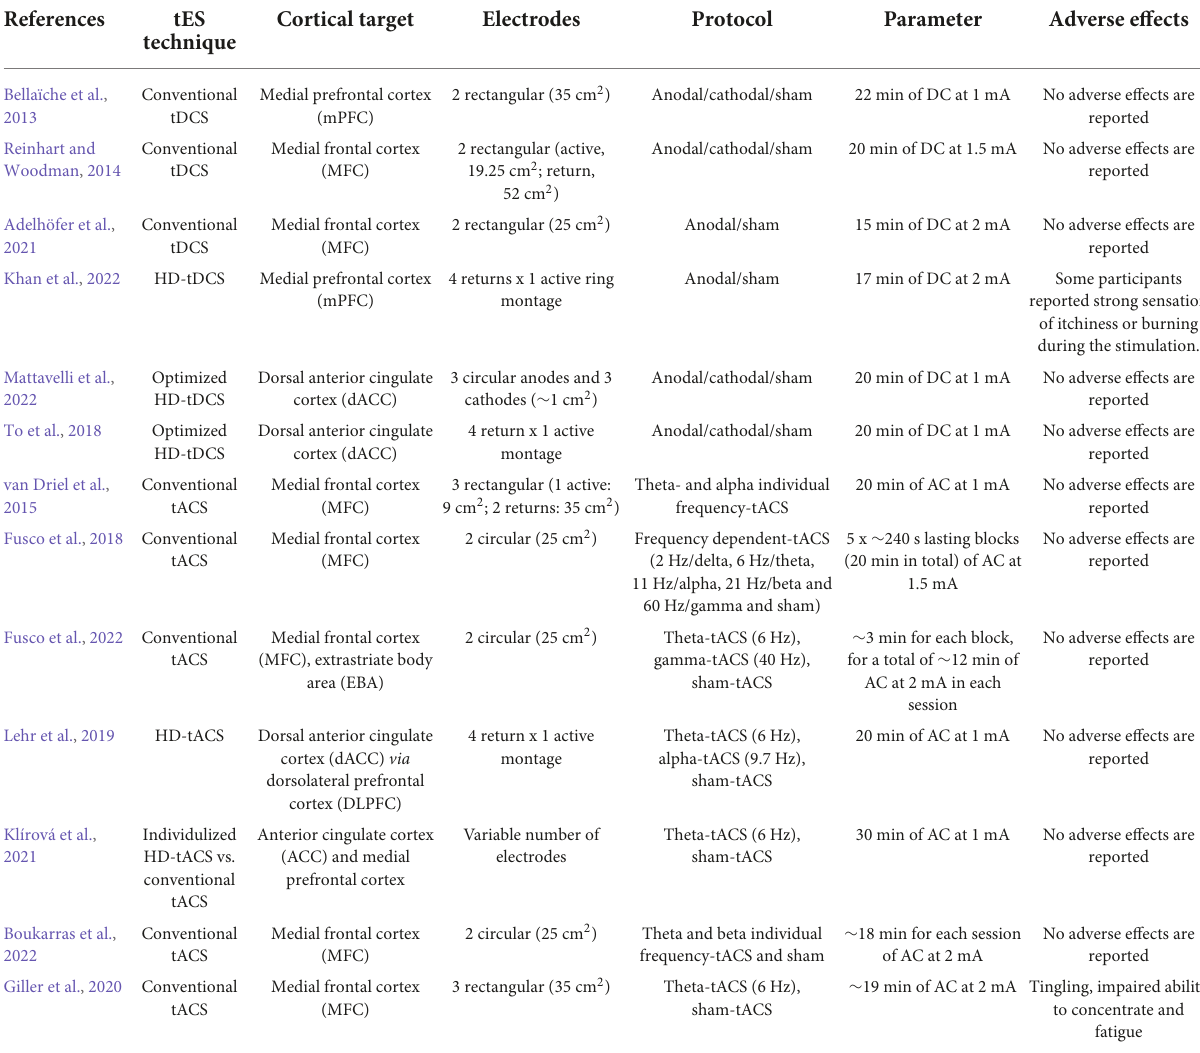
TABLE 1 Schematic summary of the studies discussed in the review and concerning methodological features of the adopted transcranial direct current stimulation (tDCS) and transcranial alternating current stimulation (tACS)